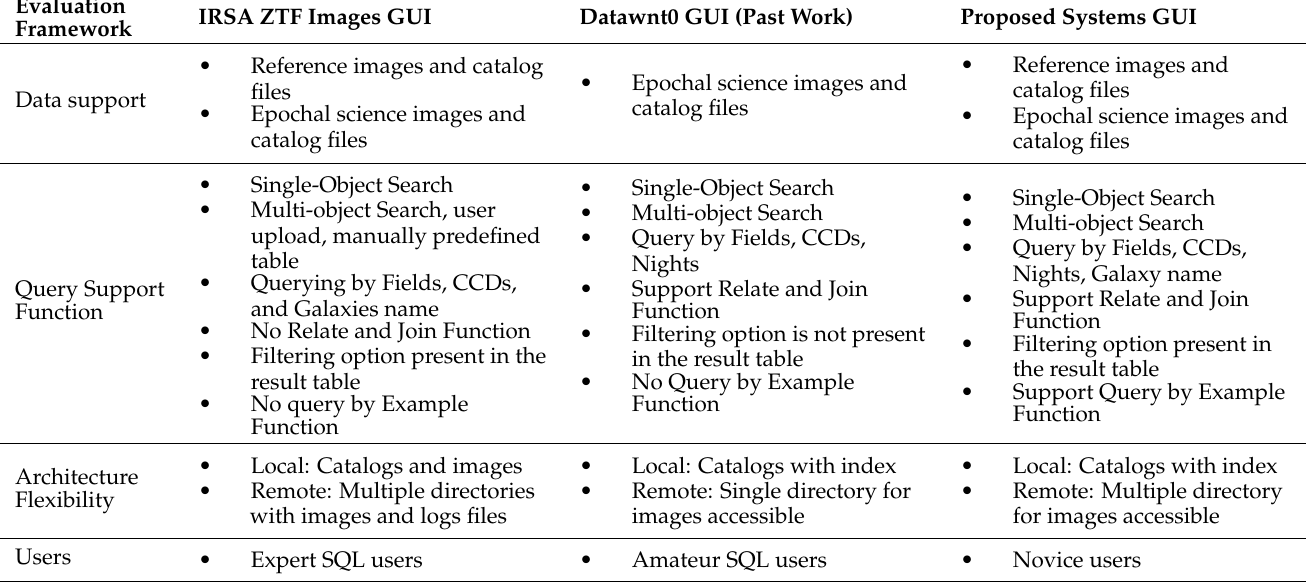
Table 5. Evaluation based on Existing Work.